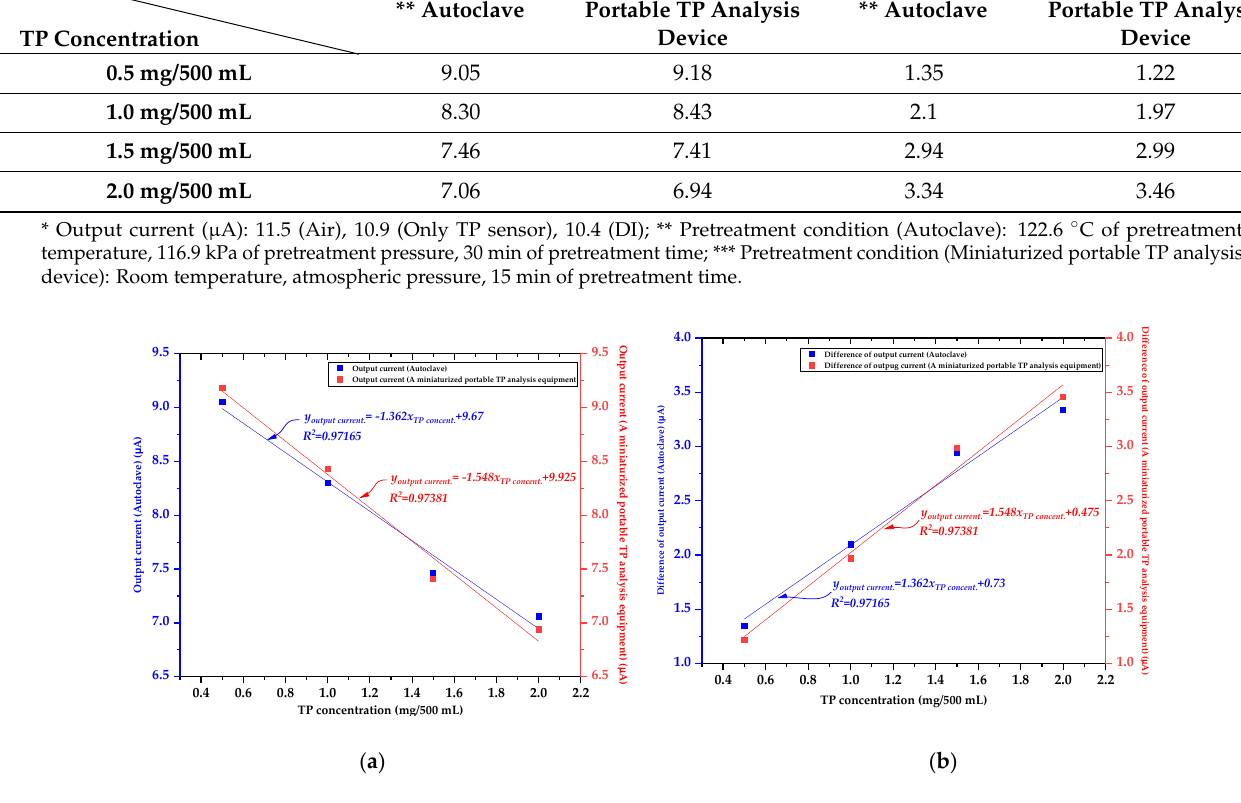
Figure 15. ( a ) Graph of the output current as a function of the TP concentration utilizing the autoclave and miniaturized TP analysis system (pretreatment conditions: 100 mA UV LED array operating current and 15 min pretreatment time) and ( b ) graph of the difference of the output current as a function of the TP concentration utilizing the autoclave and the miniaturized TP analysis system (pretreatment conditions: 100 mA UV LED array operating current and 15 min pretreatment time).